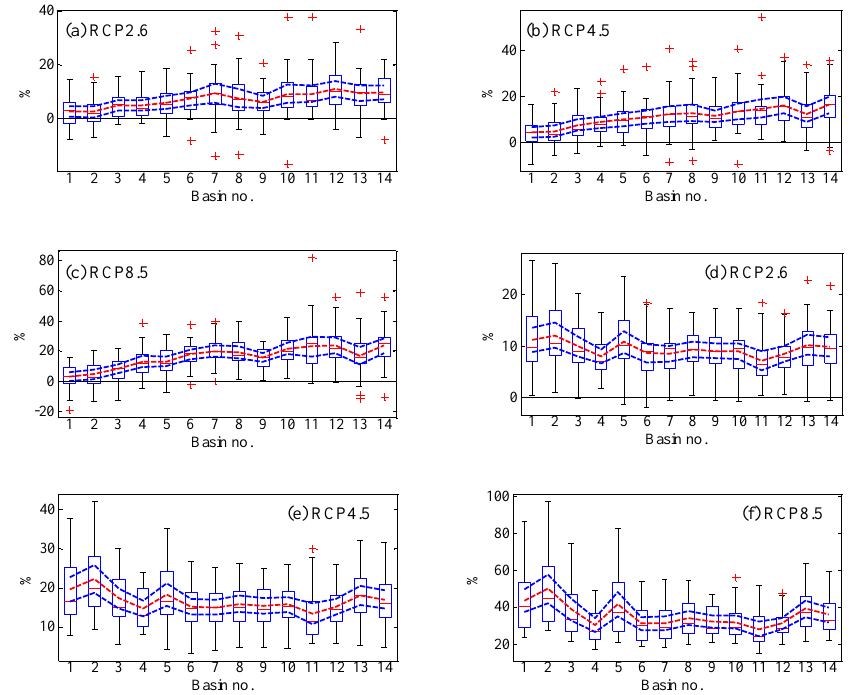
Figure 9. Box plots of relative change (%) in mean annual P under (a) RCP2.6, (b) RCP4.5, and (c) RCP8.5 scenarios and in mean annual PET under (d) RCP2.6, (e) RCP4.5, and (f) RCP8.5 scenarios calculated from 28 CMIP5 models in 14 basins for the period 2071–2100 (relative to the baseline 1971–2000). The boxes denote the interquartile model spread (range between the 25th and 75th quantiles), with the horizontal line indicating the ensemble median and the whiskers showing the extreme range of the 28 CMIP5 model simulations. Red dotted lines denote the average values of the multi-model ensemble. Blue dotted lines denote the 95% significance levels’ range of the average values of the multi-model ensemble. The basin number is consistent with that given in Fig.